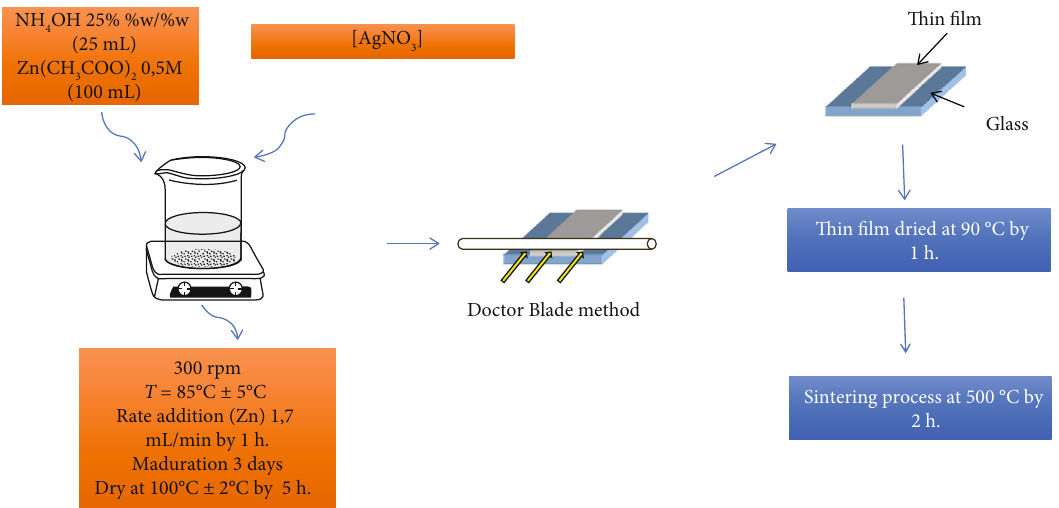
Figure 1: Synthesis procedure for ZnO and Ag-doped ZnO thin fi lms synthesized by the sol-gel method and deposited by the Doctor Blade method [33 –